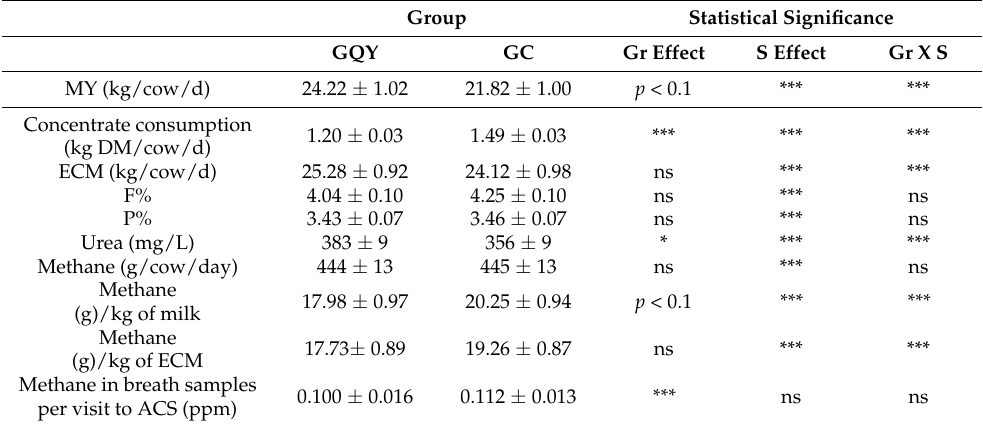
Table 7. Milk yield and concentrate consumption in both groups. Milk composition and methane emissions are also reported. The upper section shows results from the analysis of daily individual values, while the lower section shows results from monthly milk quality analysis. Values are LS means ±